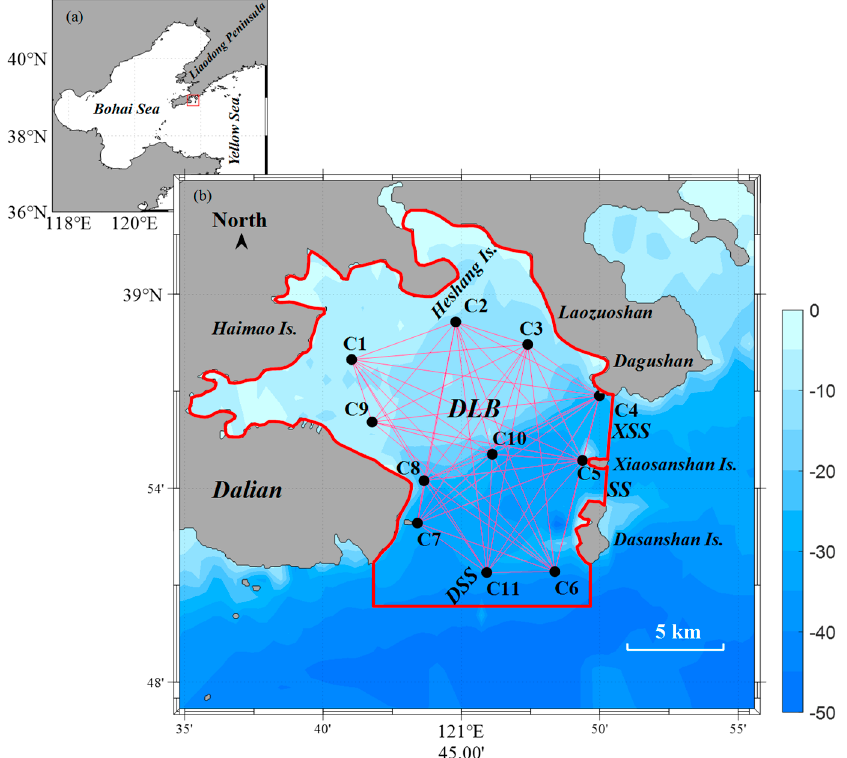
Figure 1. ( a ) Location map of the Dalian Bay. ( b ) Model domain of the 2015 Dalian Bay data analysis encircled with thick red line. The 11 acoustic stations (C1–C11) are indicated with black dots and the transmission paths to each station are indicated with thin cyan lines. The southern inlet and southeastern inlets are labelled as DSS, and XSS, and SS, respectively. The 5-km scale is indicated at the lower right corner.